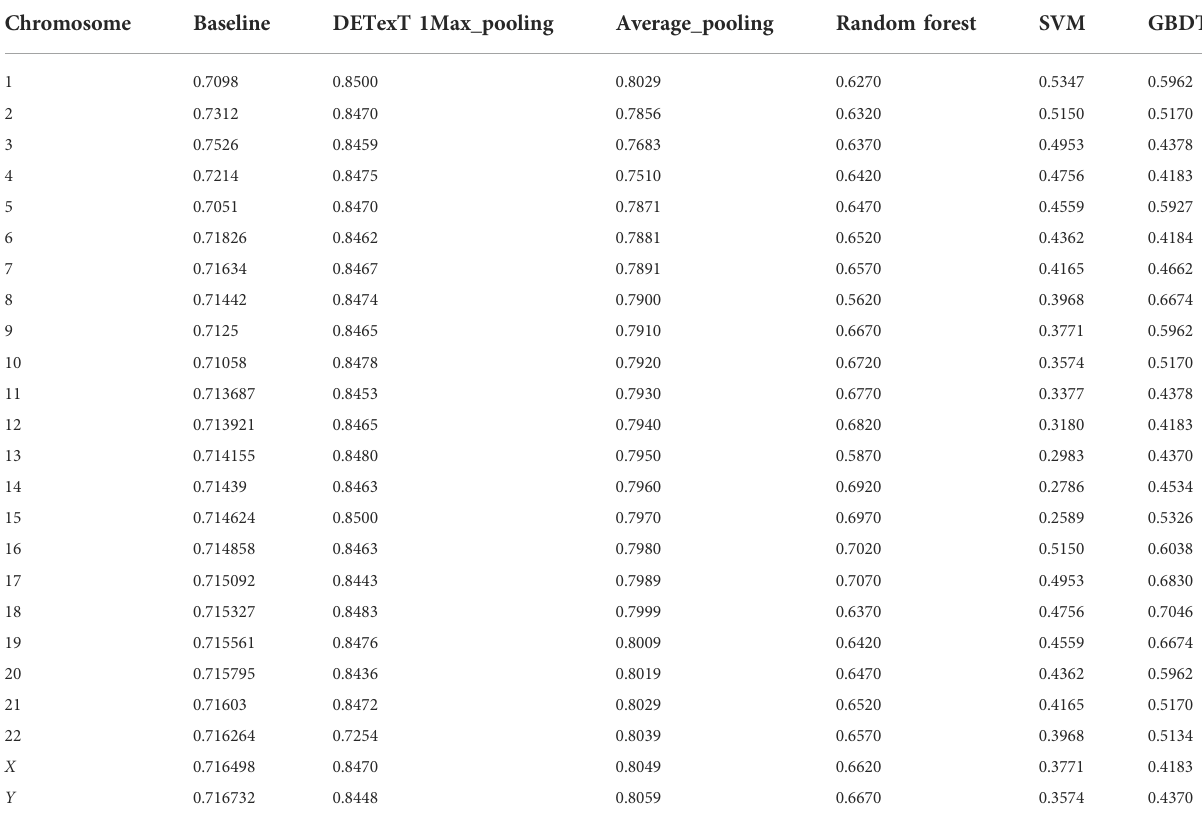
TABLE 6 Comparison experiment with average_pooling and traditional machine learning algorithms.